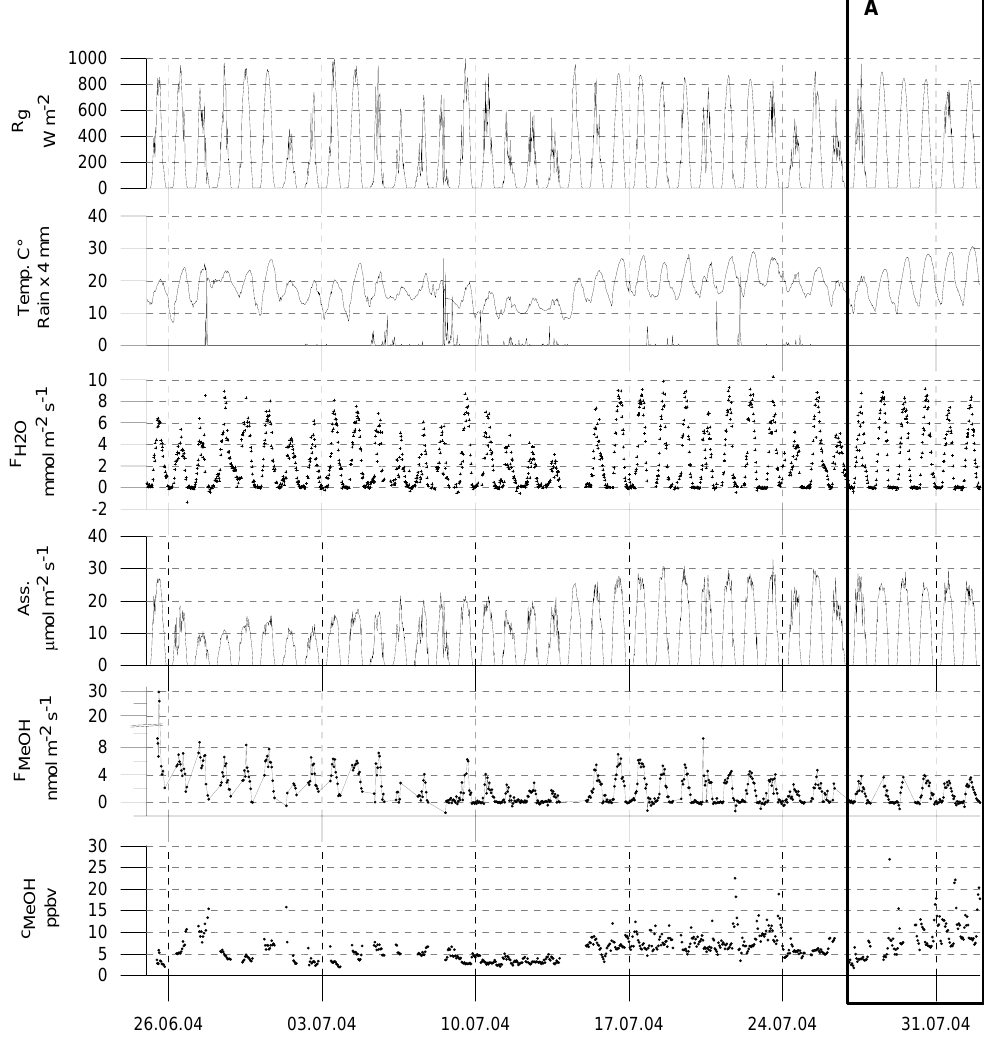
Fig. 3. Time series measured above the intensive grassland (25.06–01.08.2004), from the top to the bottom: Global radiation* ( R g ) , ) , assimilation (Ass.), methanol flux ( F MeOH ) , and methanol air temperature* (Temp.), rainfall*, water vapour flux ( F H 2 O